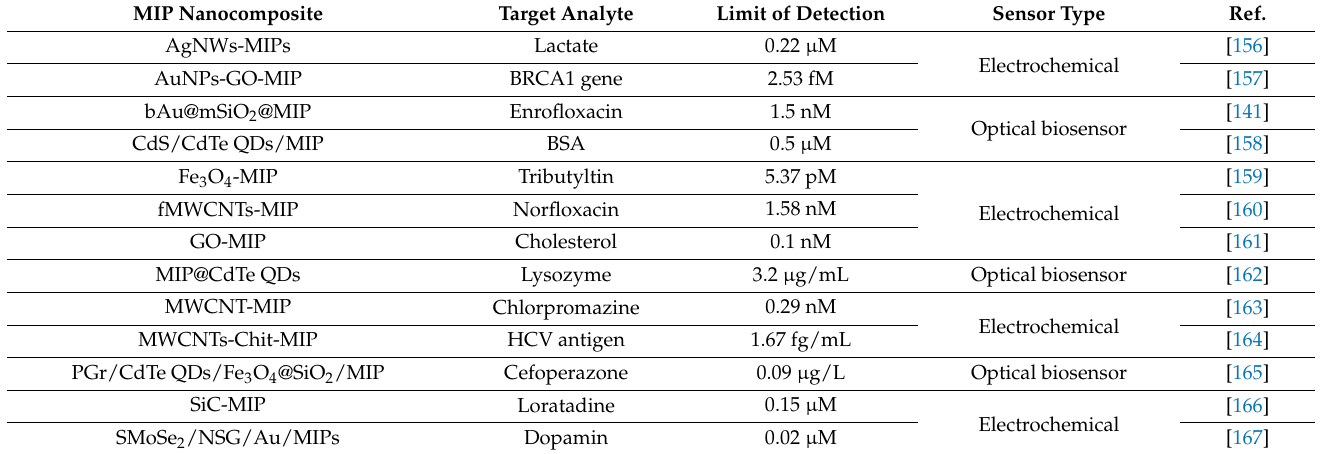
Table 4. Some nanomaterials combining MIP architectures for biosensor